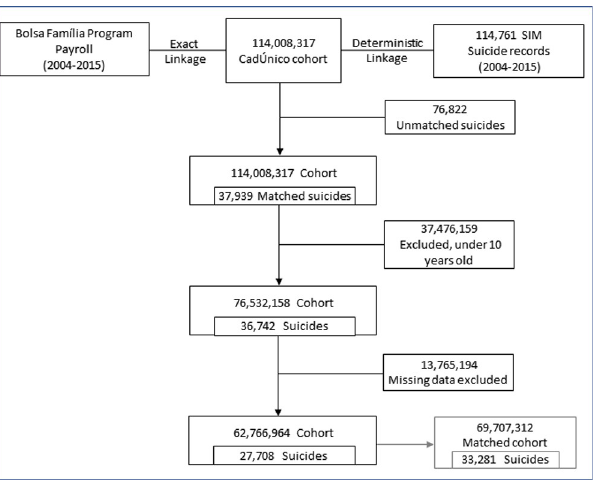
Fig 1. Flowchart AU : AbbreviationlisthavebeencompiledforthoseusedinFigs 1 ; S 1 (cid:0) S 3 ; Tables 1 (cid:0) 5 ; S 3 andS 4 Tables : Pleaseverifythatallentriesarecorrect : of selection of study population. BFP, Bolsa Famı´lia programme; SIM, Mortality Information System.